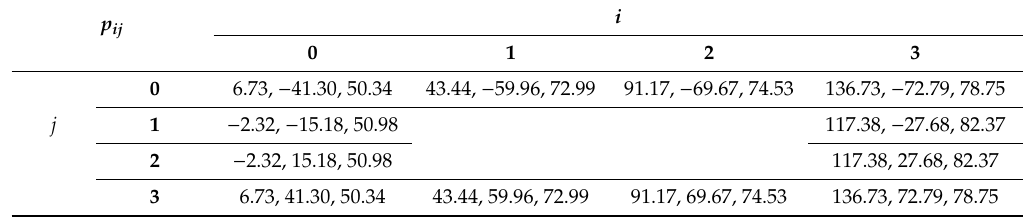
Table 2. The coordinates of 12 control points of the SQ-Coons hood surface